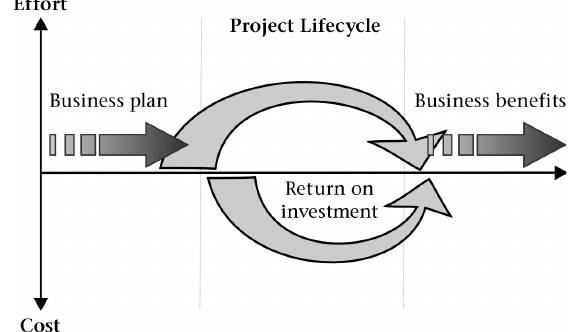
Figure 2: Delivering business benefits, balancing cost and effort Courtesy of the X-Pert Group